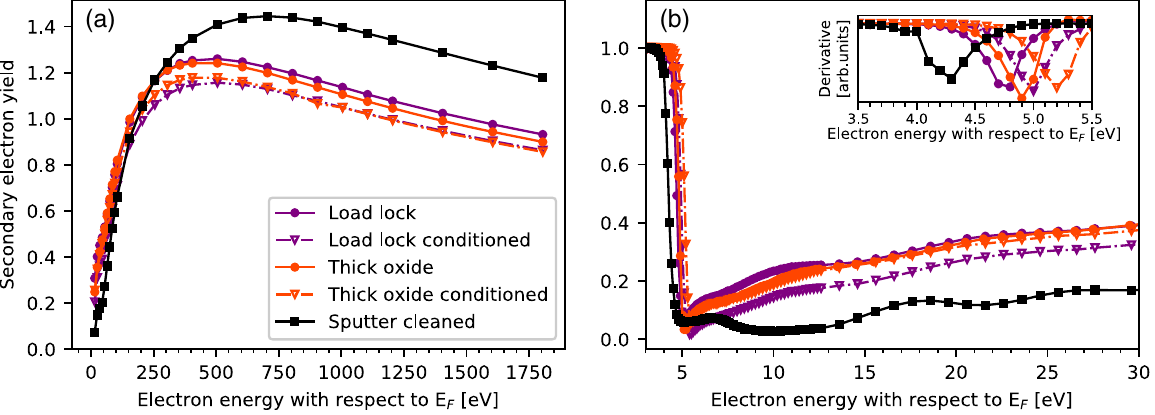
FIG. 7. (a) SEY curves from 10 to 1800 eVof a load lock and thick oxide samples, before and after conditioning, (b) low energy SEY curves, inset: derivative of the SEY curves in the vacuum level region. The sputter-cleaned state is given for